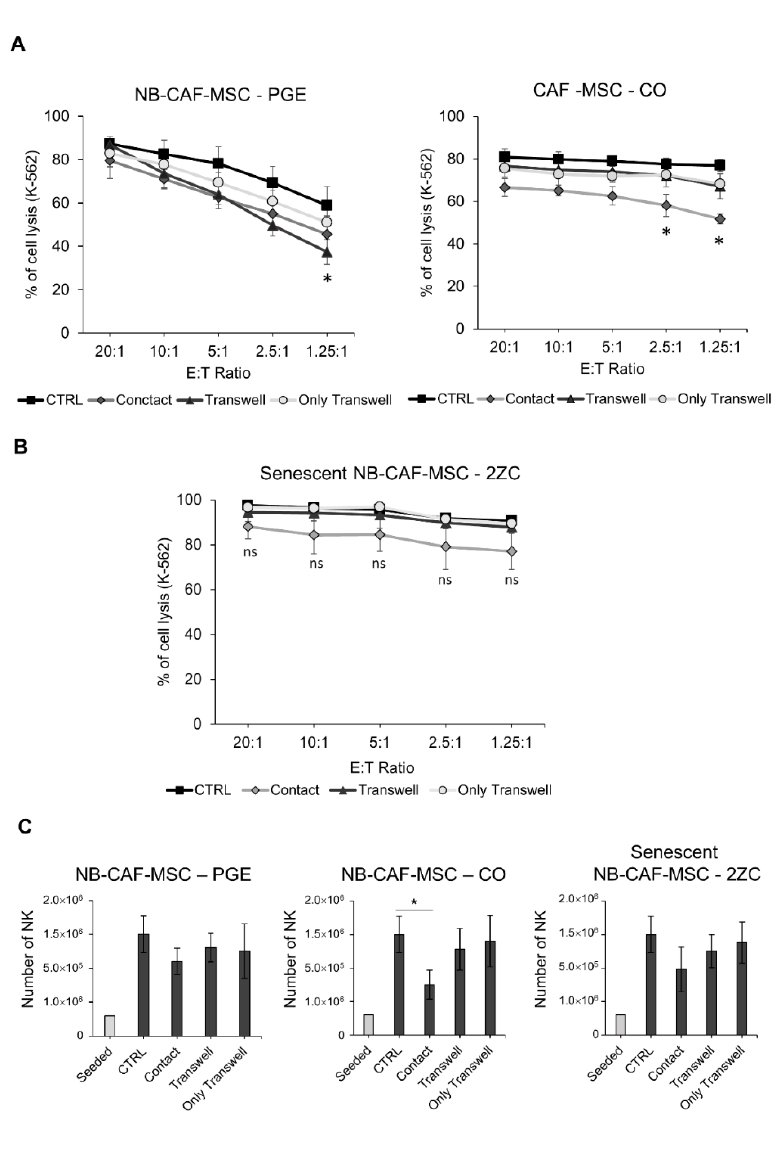
Figure 7. Evaluation of NK cell cytotoxic activity and proliferative potential after co-culture with senescent NB-TA-MSC cultures. NK-cell cytotoxicity assays against CMFDA-labelled K-562 cells after co-culture with ( A ) Senescent NB-TA–MSC-CO, PGE ( B ) Senescent NB-TA–MSC-2ZC culture, under direct cell-cell Contact or under Transwell conditions. Percentages of lysed cells were expressed as mean ± SD ( n = 3). ns = not significant. ( C ) Live NK cell number (PI − ) after co-culture with senescent NB-TA–MSC cultures. Co-culture of senescent NB-TA-MSC-PGE and 2ZC with NK cells did not affect cell number compared to CTRL, while the co-culture with senescent NB-TA-MSC-CO in direct-contact condition caused a slowdown of NK cells number. Data were expressed as mean ± SD ( n = 6). * p < 0.05 vs.